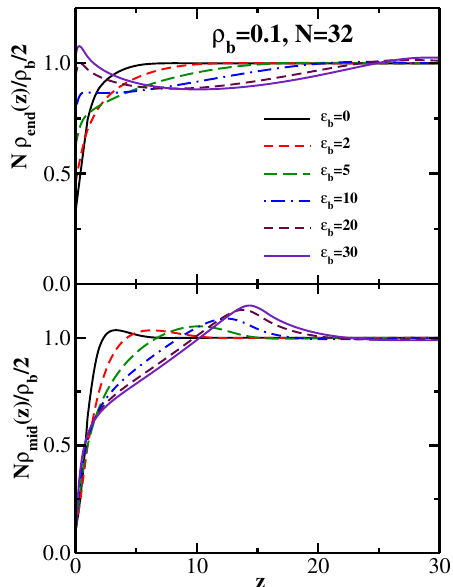
Figure 8. Normalized end-monomer (upper part) and mid-monomer (lower part) density profiles, 2 N ρ end ( z ) / ρ b and 2 N ρ mid ( z ) / ρ b , plotted vs. z , for the case ρ b = 0.1, N = 32, and several choices of (cid:101) b , as indicated in the key. Reproduced from [43] with the permission of AIP